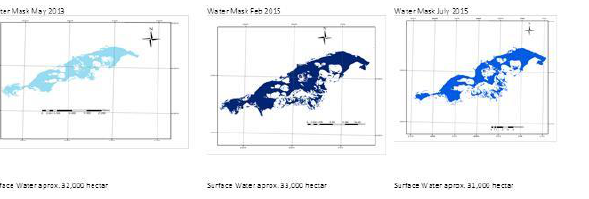
Figure (6) Lake Burullus Water Mask for acquired Imaginary